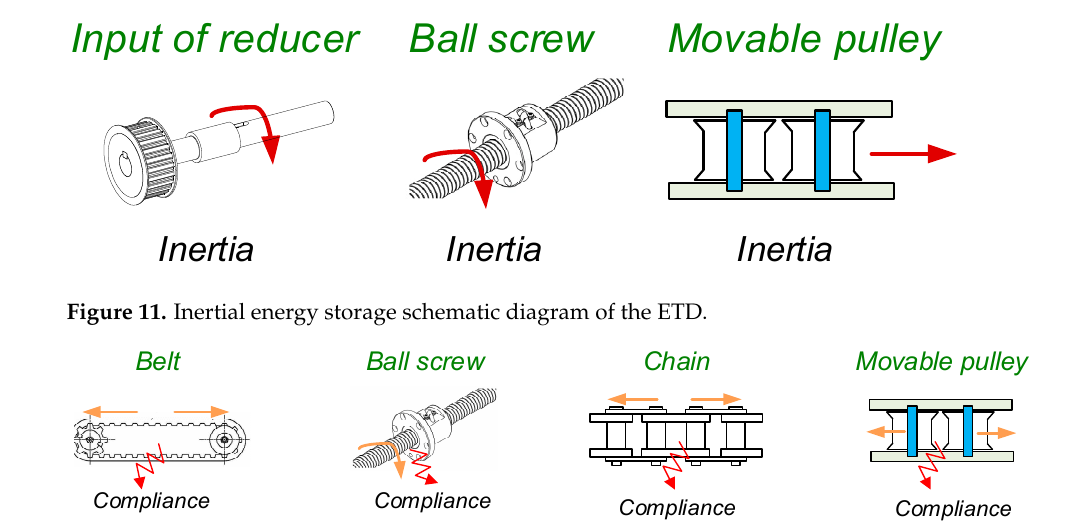
Figure 10. Motion damping schematic diagram of the ETD.